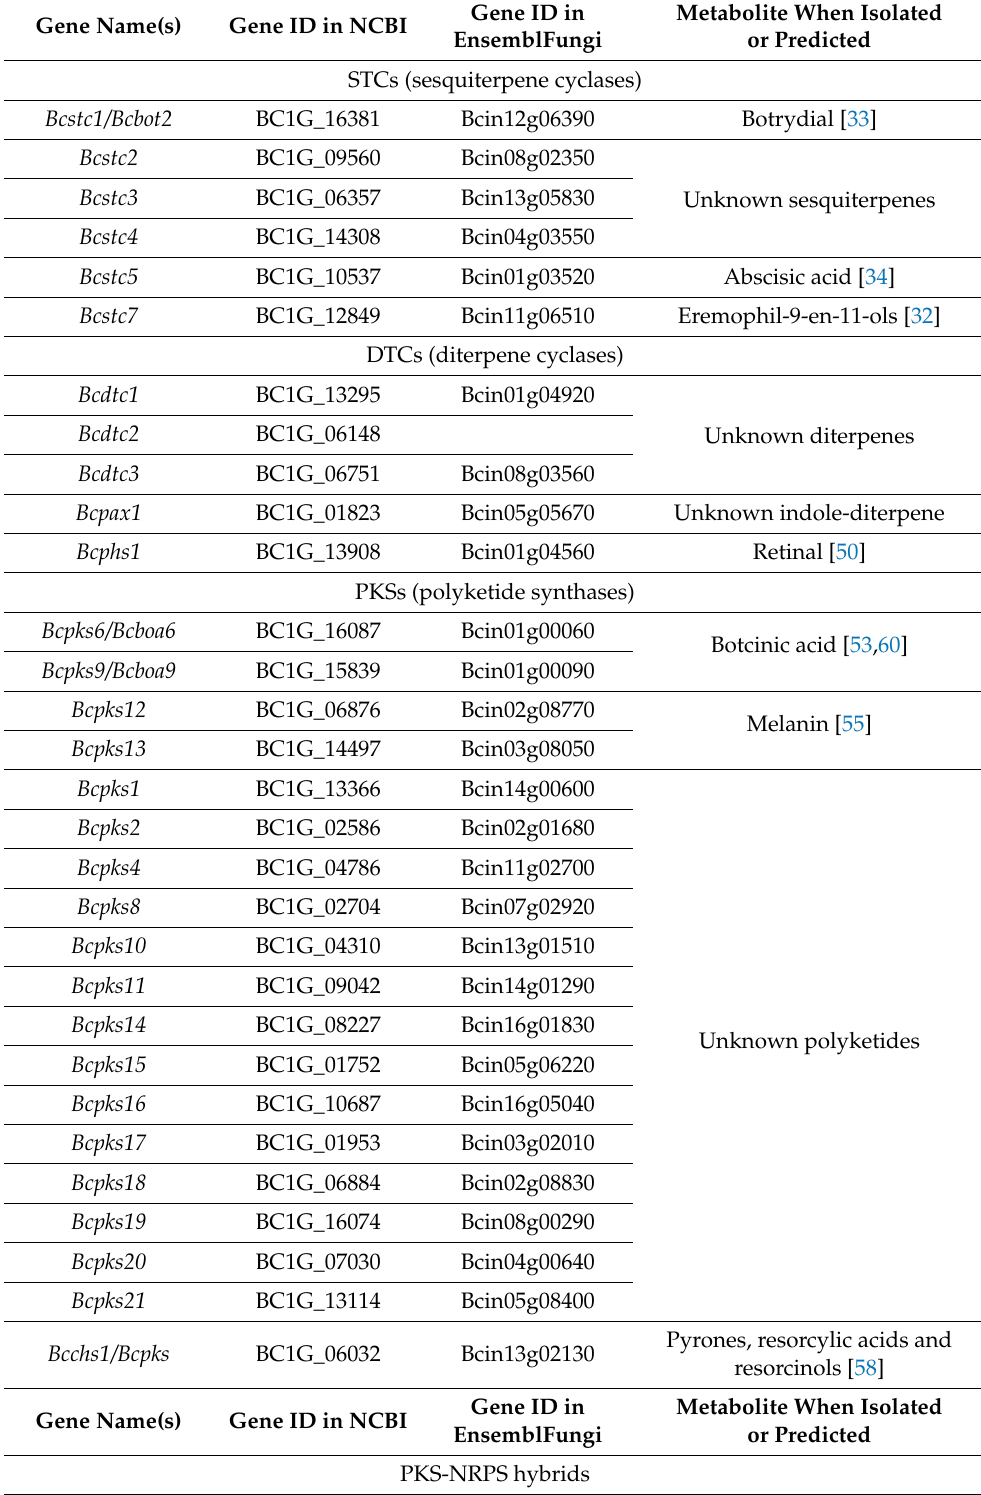
Table 1. Repertoire of secondary metabolism key enzymes (KEs) in B. cinerea